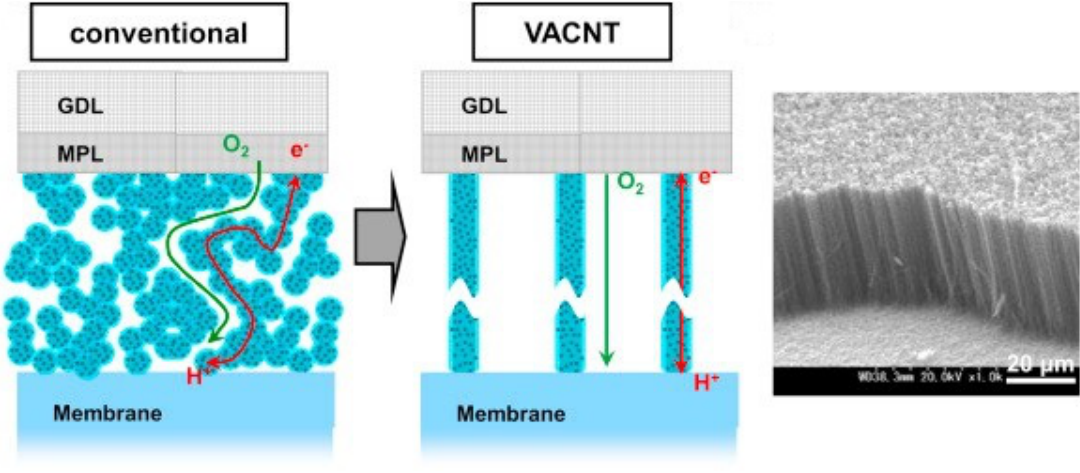
Figure 9. Concept of VACNT electrodes [131] .